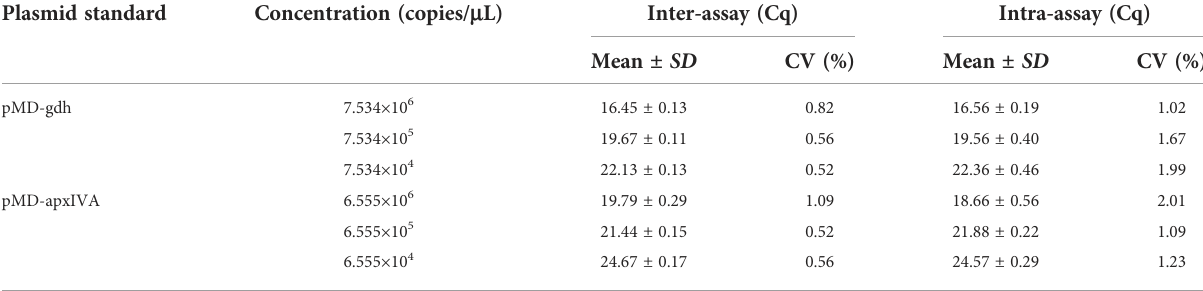
TABLE 2 Evaluation of reproducibility of TaqMan real-time PCR. Plasmid